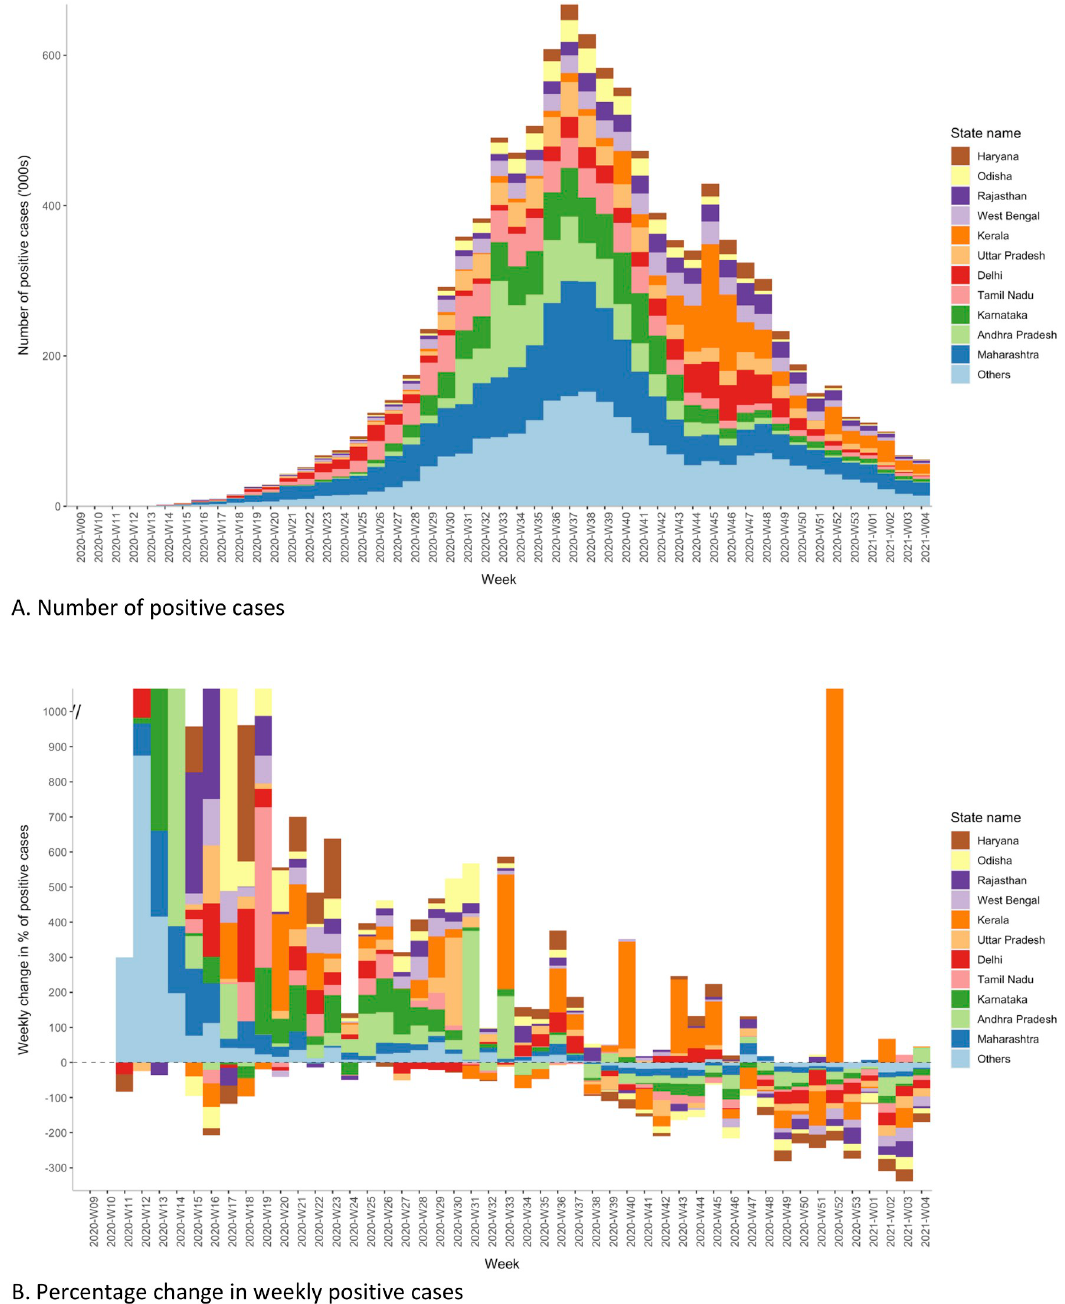
Fig 3. Distribution of laboratory-confirmed COVID-19 cases and percentage change by week and the state of residence, India (March 2020 to January 2021). The epi-curve based on confirmation date was shifted more to the right than that based on sample collection date, even though the peak weeks did not differ between these two curves (Fig 5A). However, we noted an unusually high number of cases confirmed on week 45, whereas this was not the case with the sample collection curve. Examination of the state epi-